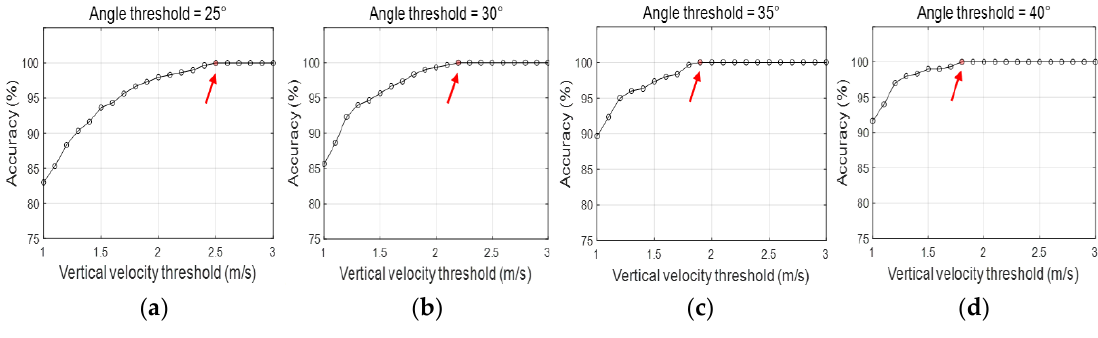
Table 3. Sensitivity, specificity, and accuracy obtained using threshold combinations.